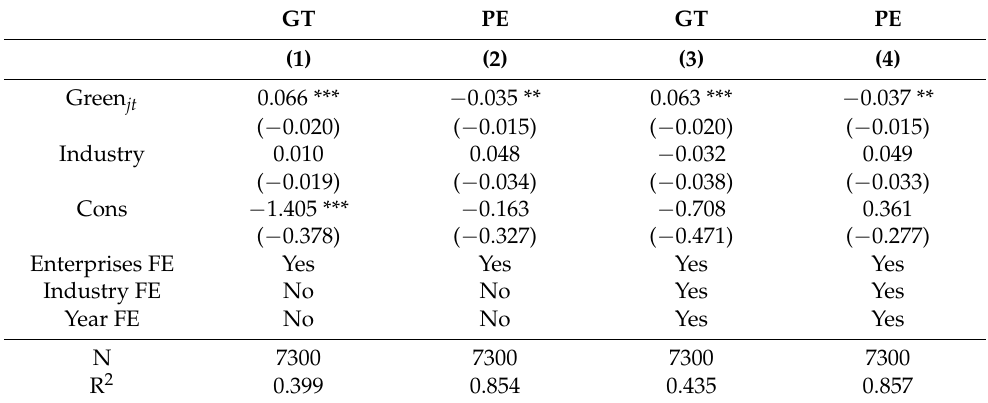
Table 3. Benchmark